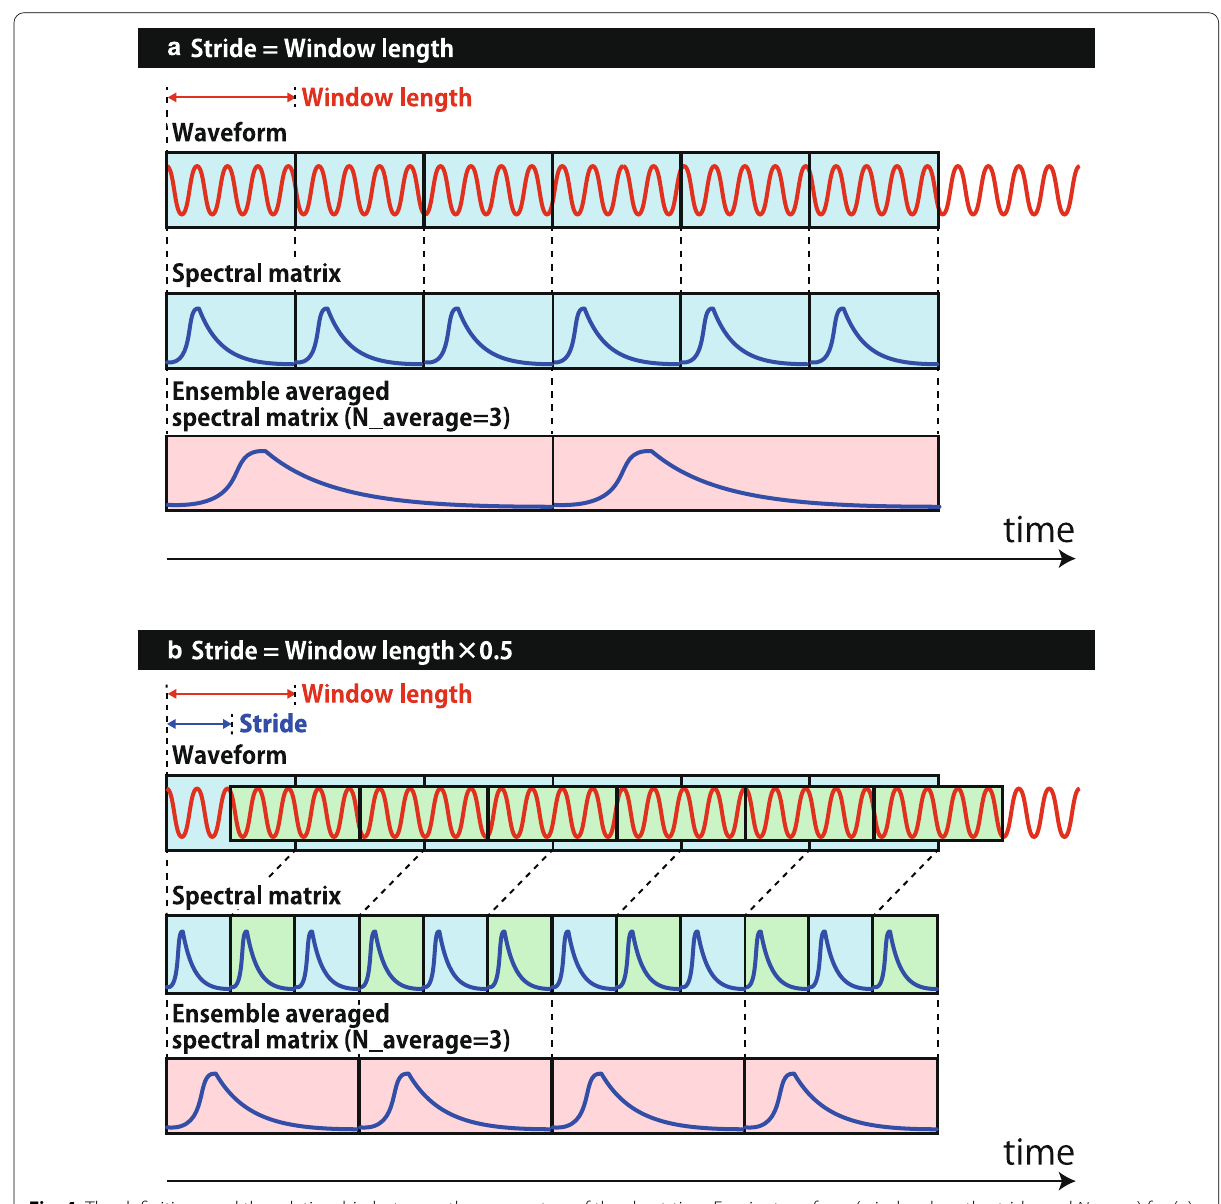
Fig. 4 The definitions and the relationship between the parameters of the short‑time Fourier transform (window length, stride, and N average ) for ( a ) stride window length and ( b ) stride window length × = =